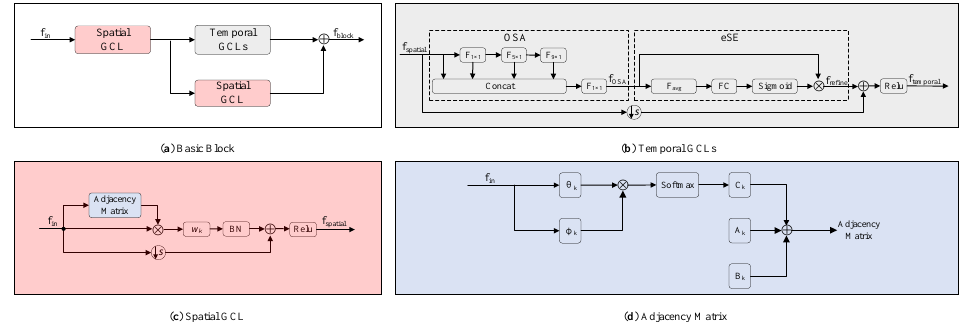
Figure 2. The details of the basic block for EEGCN ⊕ indicates the elementwise addition operation and ⊗ indicates the matrix multiplication operation. In Figure 2b, F 1×1 , F 5×1 and F 9×1 denote 1 × 1, 5 × 1 and 9 × 1 convolution layer respectively, F avg is global average pooling, FC is fully-connected layer. In Figure 2d, A k denotes the fixed natural structural graph illustrated in Figure 3, B k denotes the layer adaptive adjacency matrix, C k denotes the sample adaptive adjacency matrix, θ k and ϕ k denote the two embedding functions.